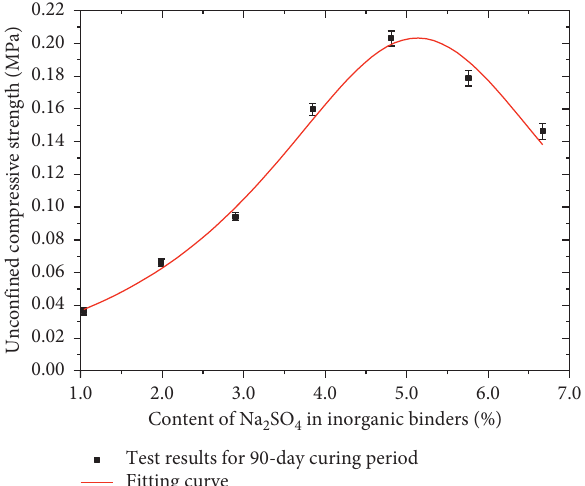
Figure 18: Influence of Na 2 SO 4 content in inorganic binders on UCS of sample at the 90 d curing